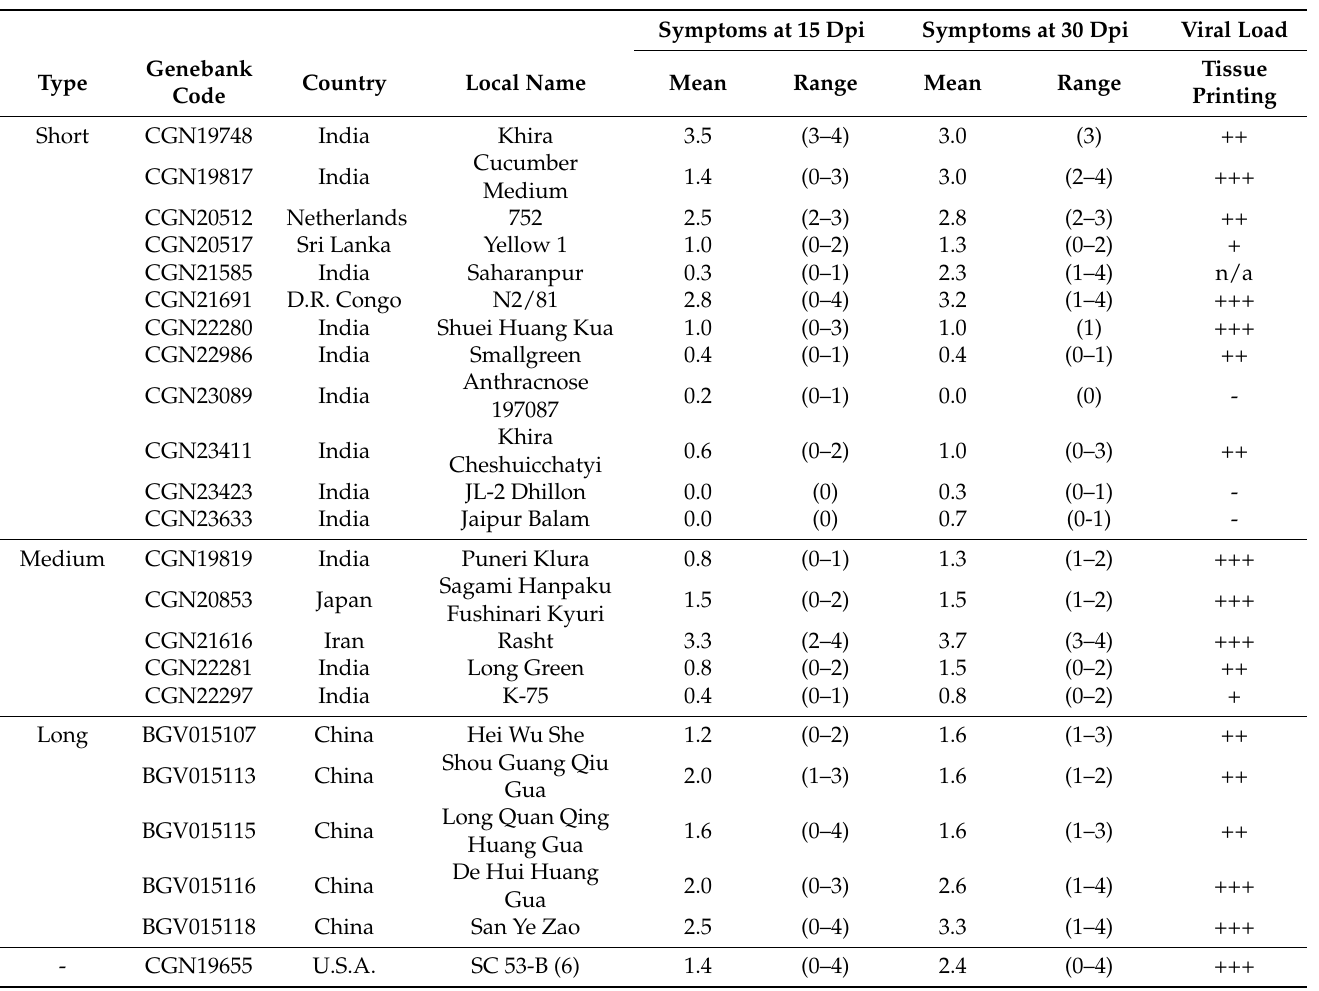
Table 2. Response of C. sativus accessions from different origins to the mechanical inoculation with ToLCNDV. Mean and range of symptoms scored in plants per genotype (at 15 and 30 dpi) according to the scale: 0, absence of symptoms; 1, mild symptoms; 2, moderate symptoms; 3, severe symptoms; 4, very severe symptoms or plant death. Mean score of viral load detected in each plant of the assayed accessions by tissue printing at 15 dpi according to the scale of high (+++), intermediate (++), low (+), or absent (-) viral accumulation. Data not available are shown as